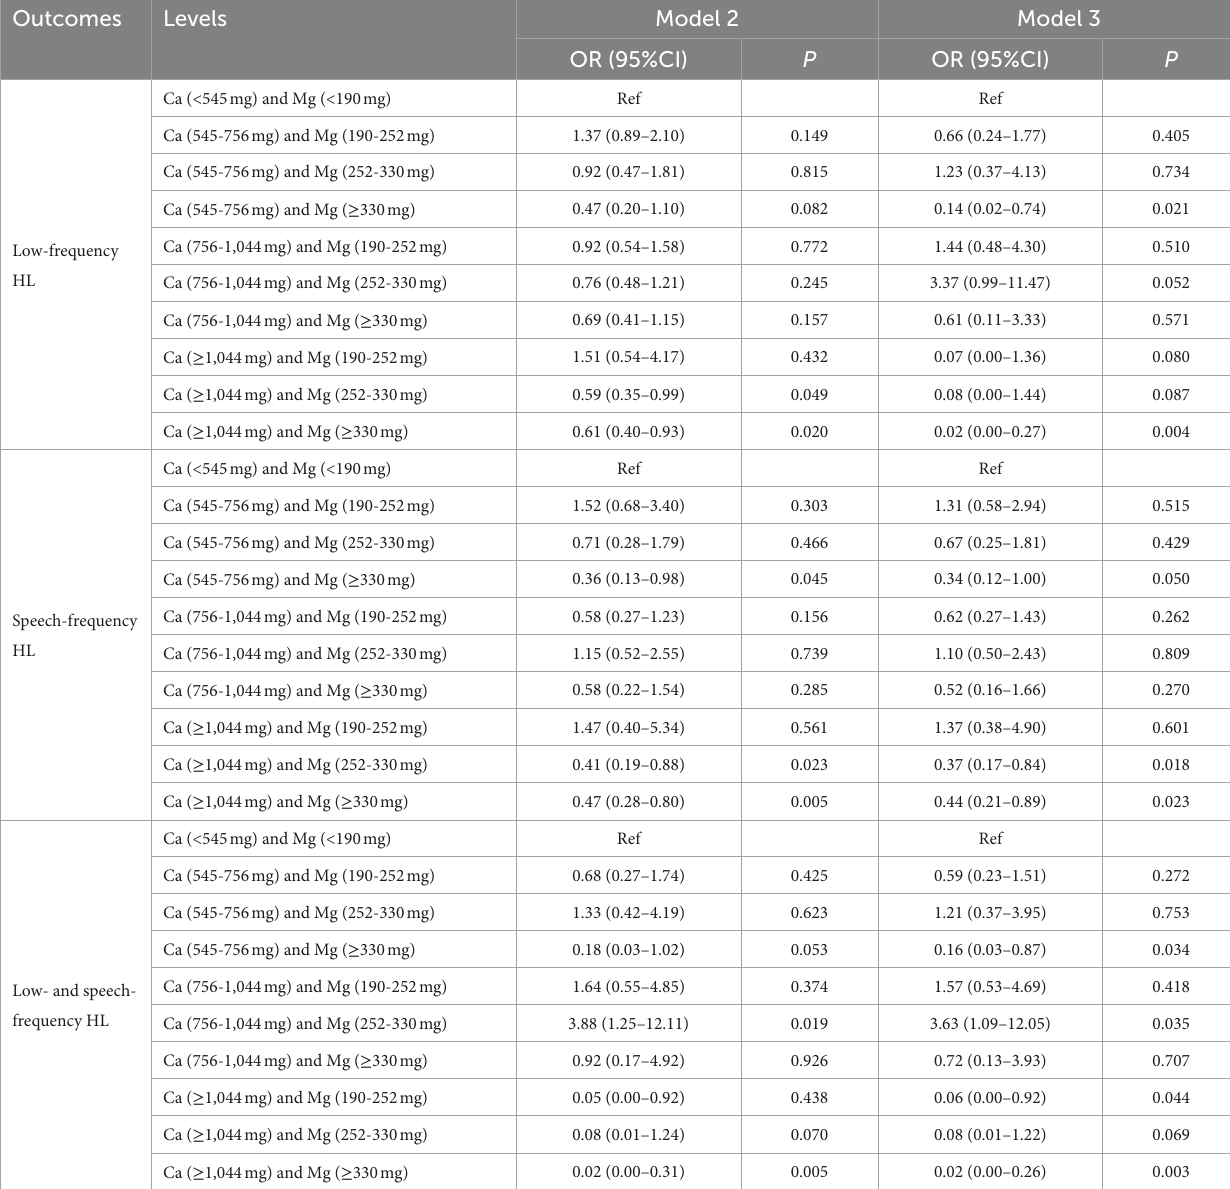
TABLE 3 Association between combined intake of different levels of calcium (Ca) and magnesium (Mg) and hearing loss (HL). Outcomes